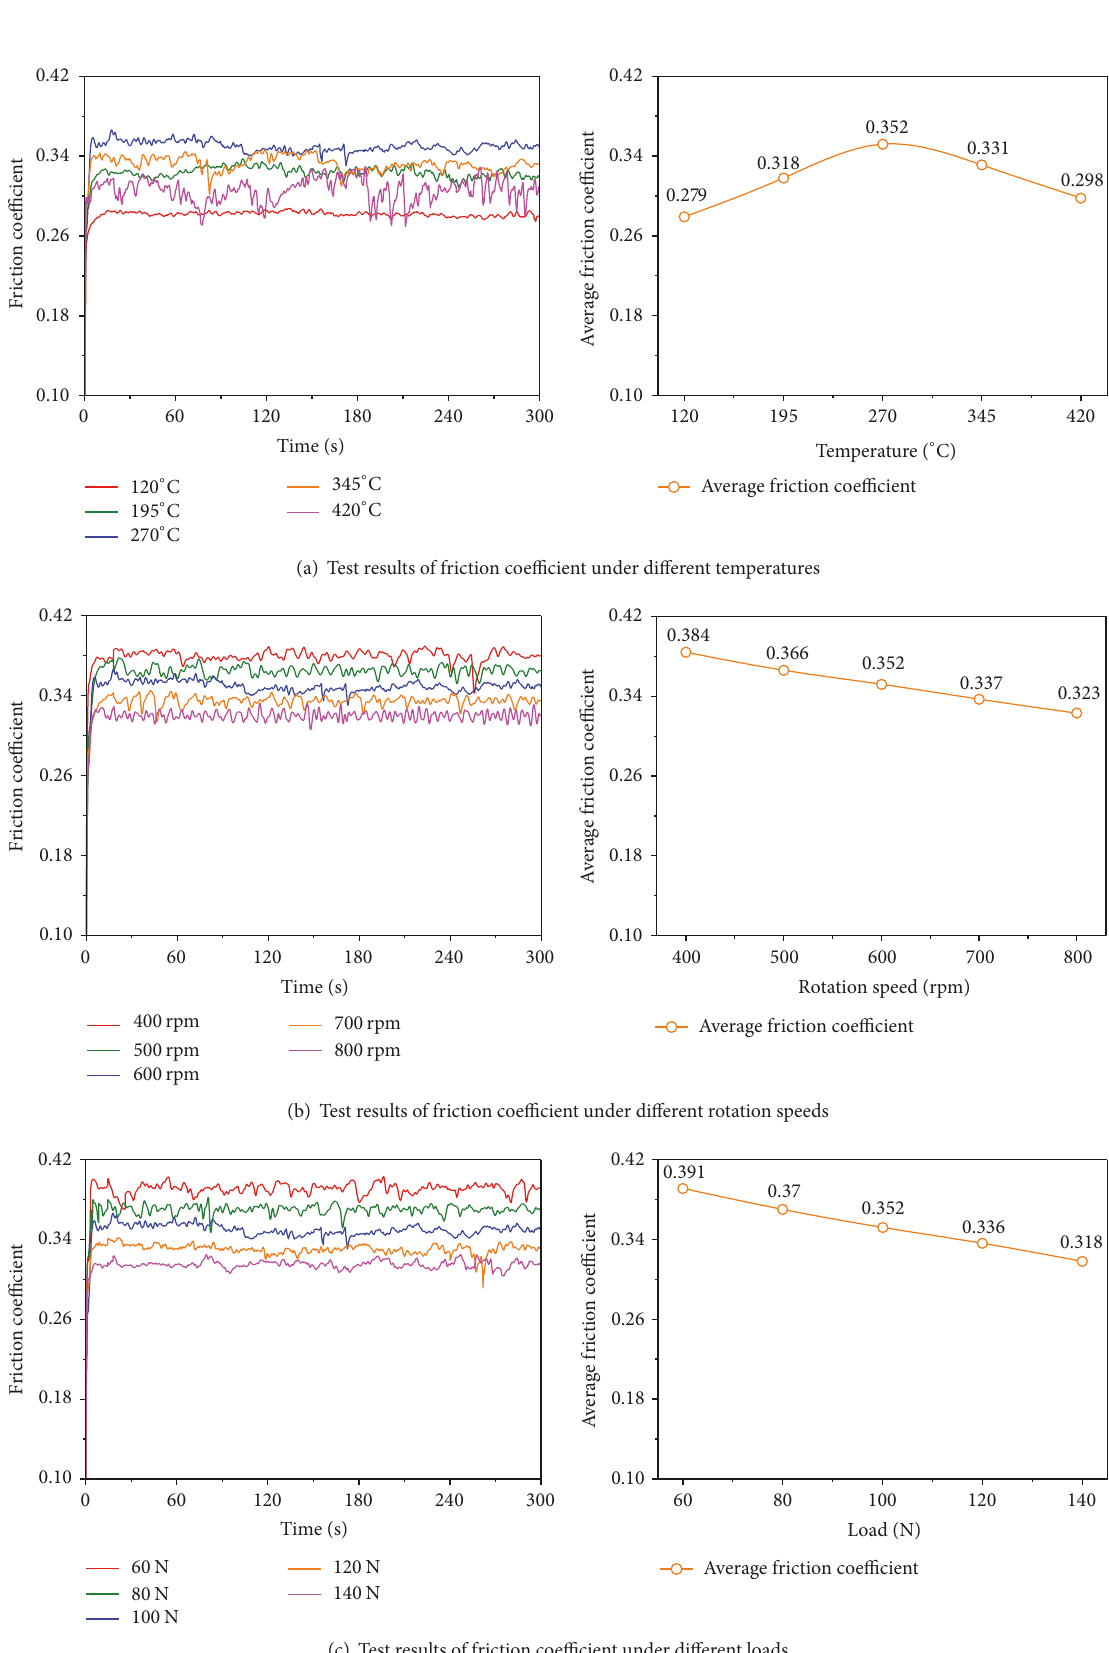
Figure 4: Test results of friction coefficient under different temperatures, rotation speeds, and